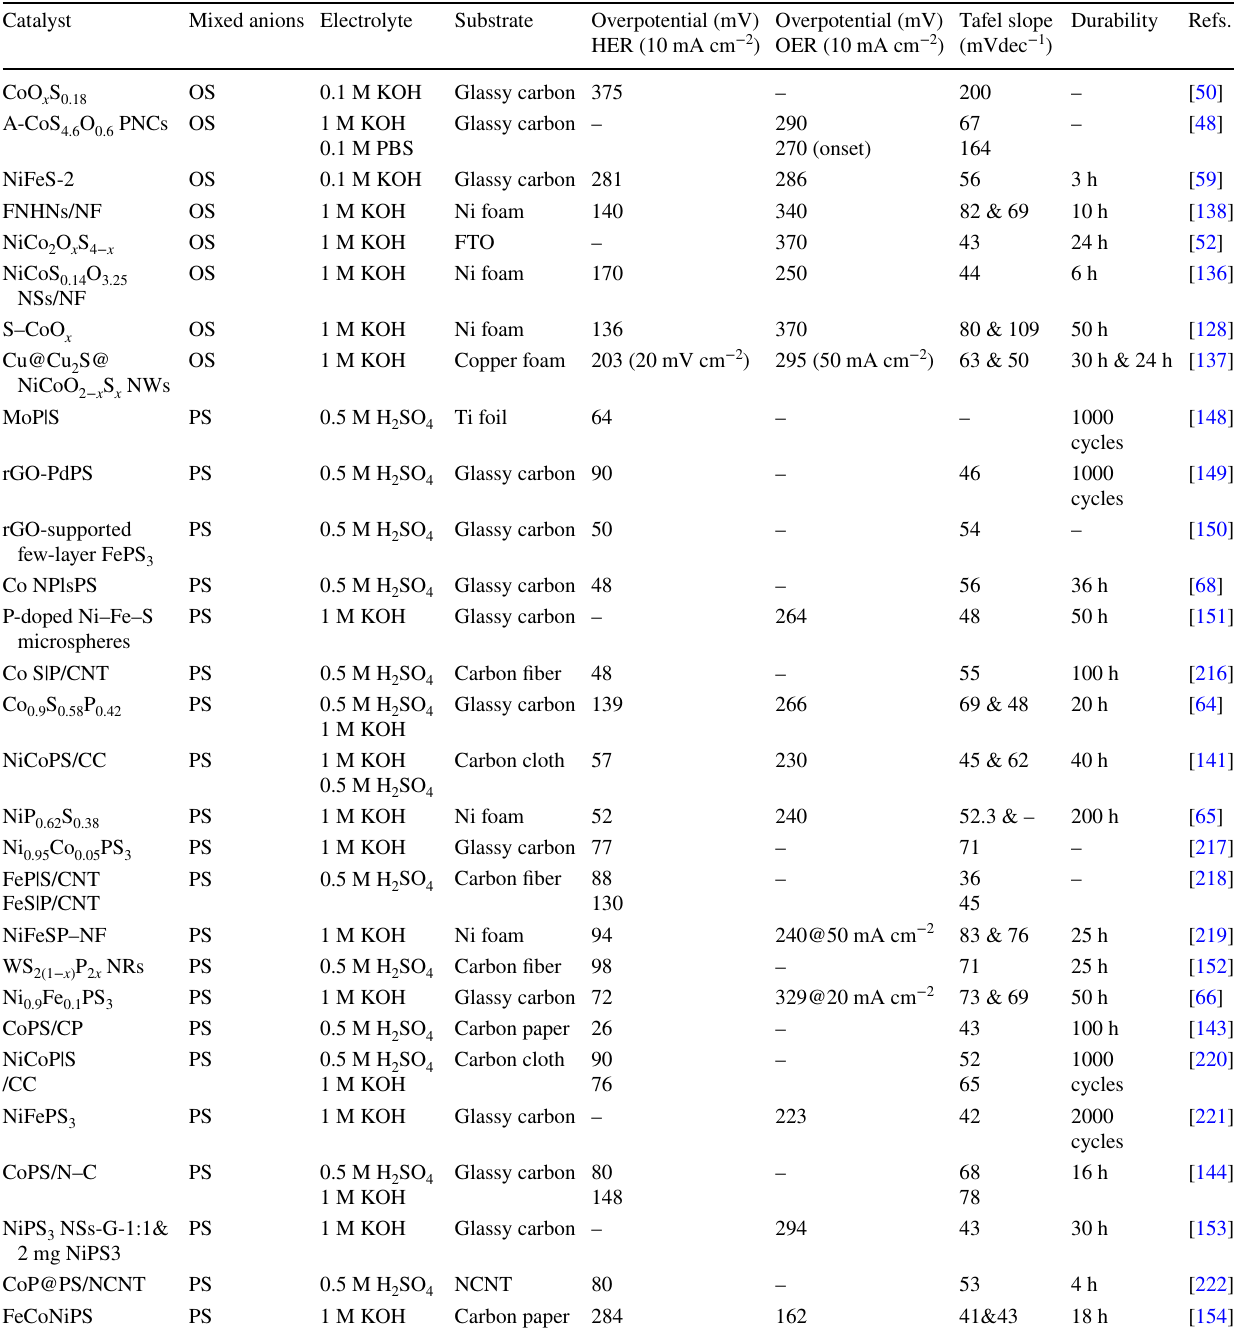
Table 2 Comparison of the OER and HER performance of typical mixed chalcogenides (oxysulfides, phosphosulfides)-based electrocatalysts Catalyst Mixed anions